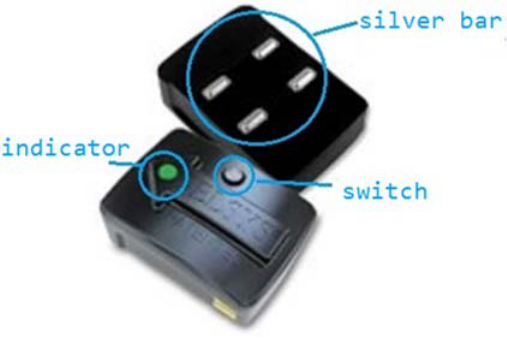
Figure 2. Trigno sensor.